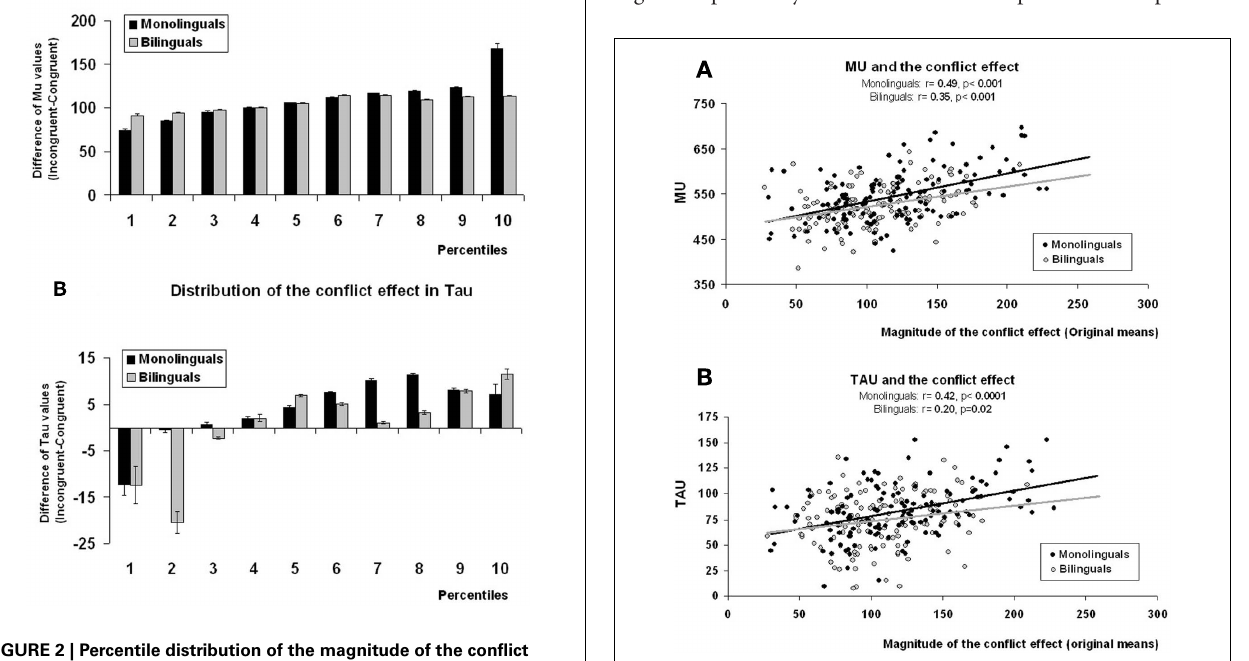
FIGURE 3 | Correlations between the magnitude of the conflict effect and μ (A) and τ (B) in monolinguals and bilinguals